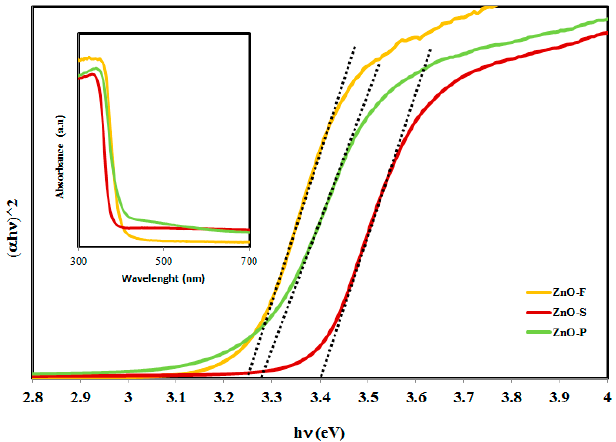
Figure 6. Absorption edge (inset) and band gap of the prepared ZnO-NPs.